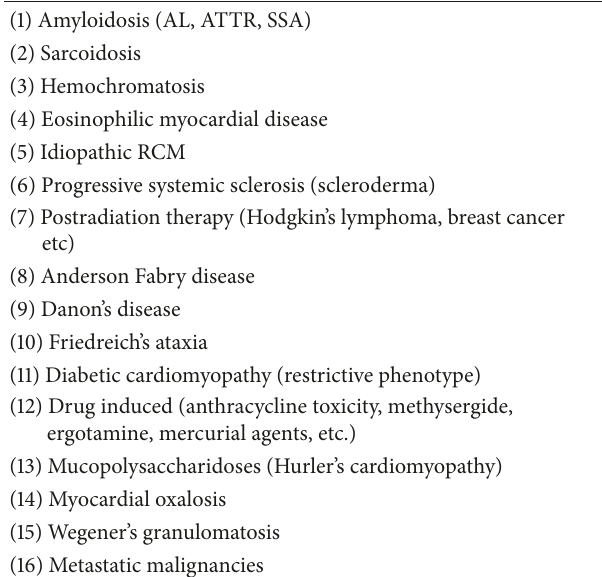
Table 1: Causes of restrictive